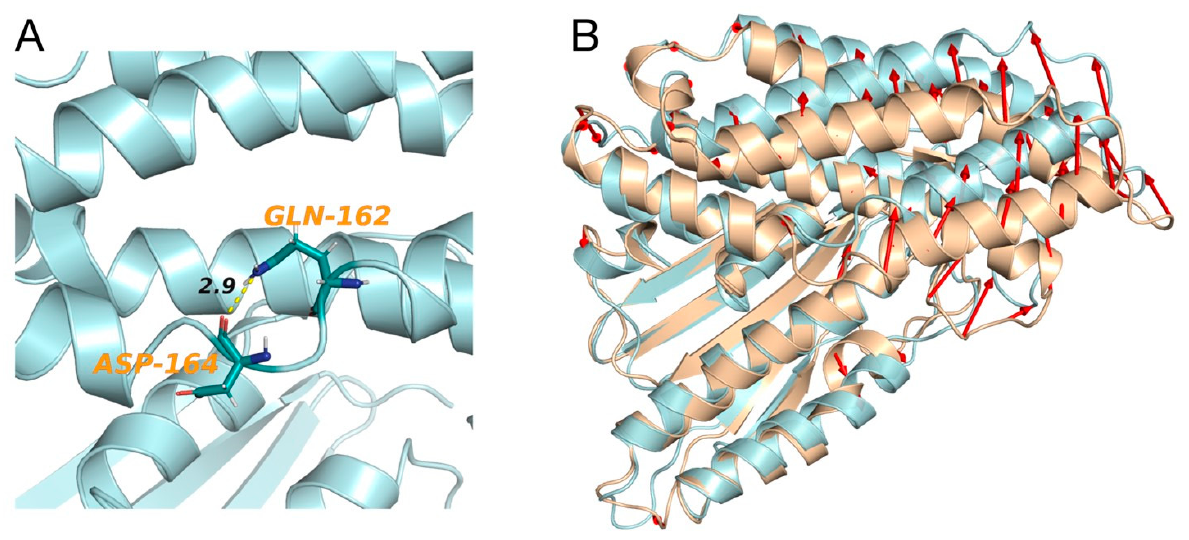
Figure 3. (A ) Interaction (distance in angstrom) between Gln162 and Asp164 of BCKDK-p.His162Gln after 500 ns of MD simulation. ( B ) Superimposition of BCKDK-wt (light brown) and BCKDK-p.His162Gln (light blue) after MD simulations. The red arrows represent a deviation higher than 3 Å.